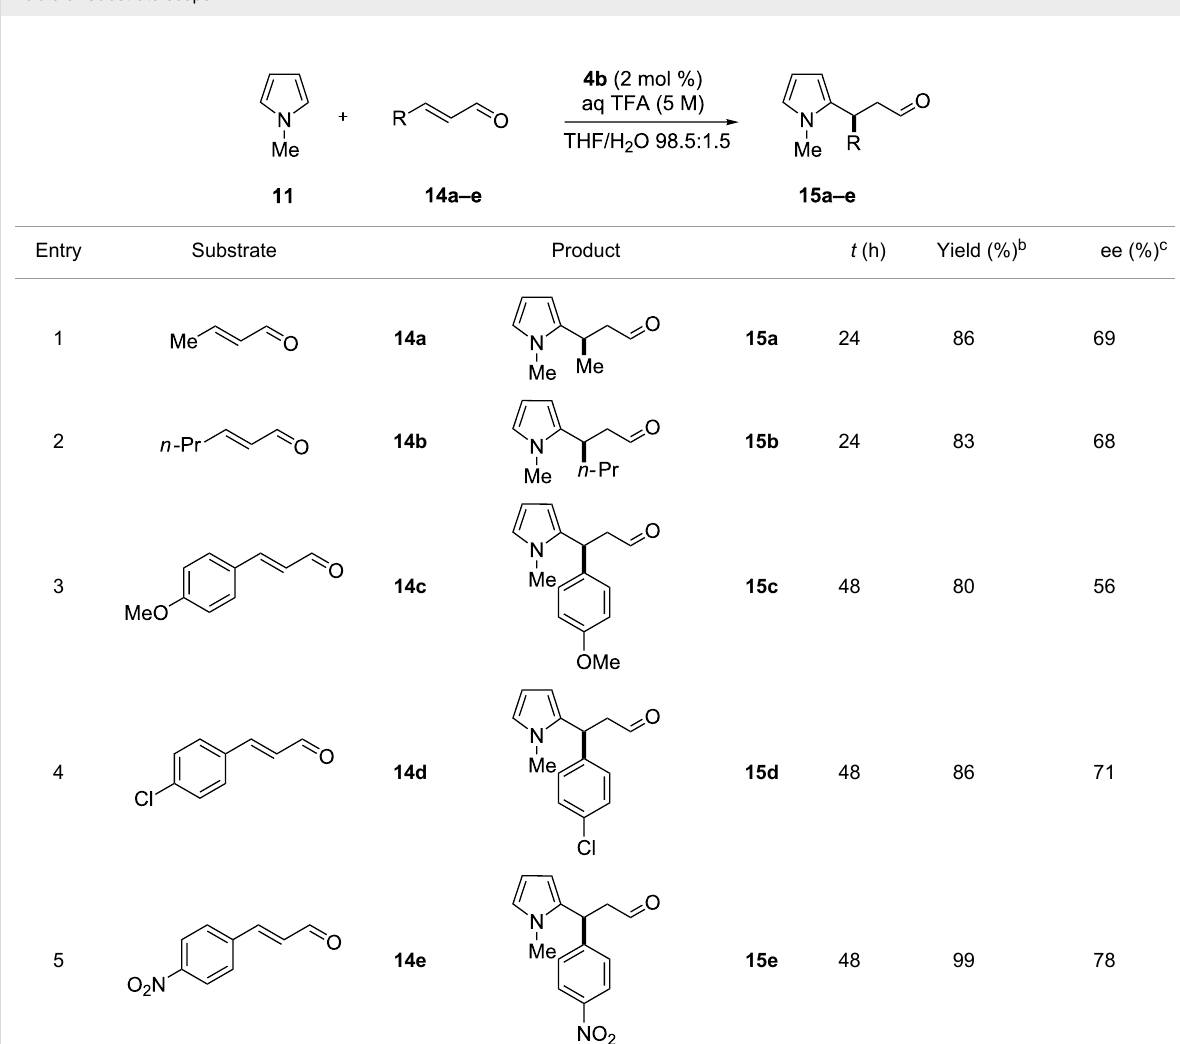
Table 5: Substrate scope.